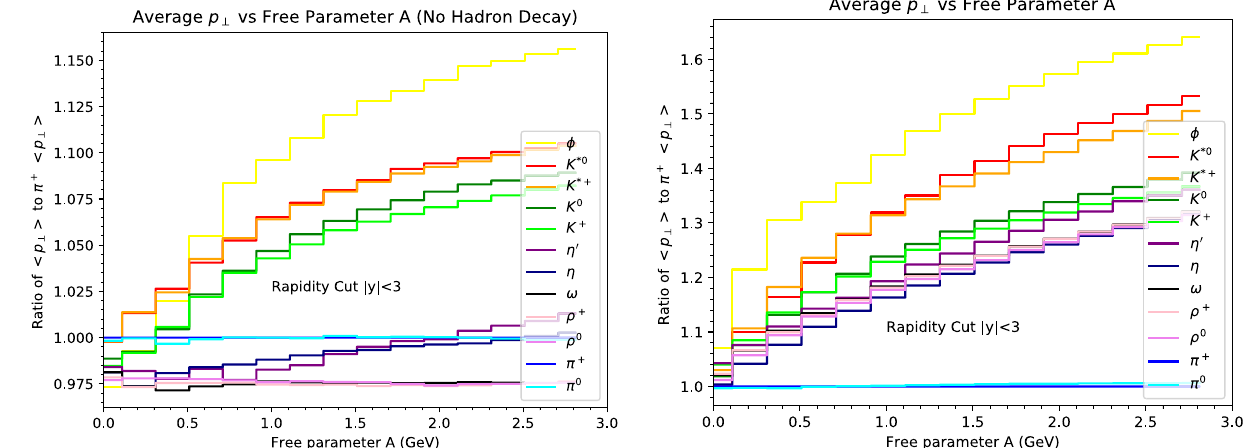
Fig. 5 Ratio (cid:4) p ⊥ (cid:6) Meson / (cid:4) p ⊥ (cid:6) π + for various meson species, as a function of A for fixed τ 0 = 2 GeV − 1 , before (left) and after (right) including the effects of hadron decays. In both plots, a cut requiring | y | < 3 was imposed to suppress endpoint effects